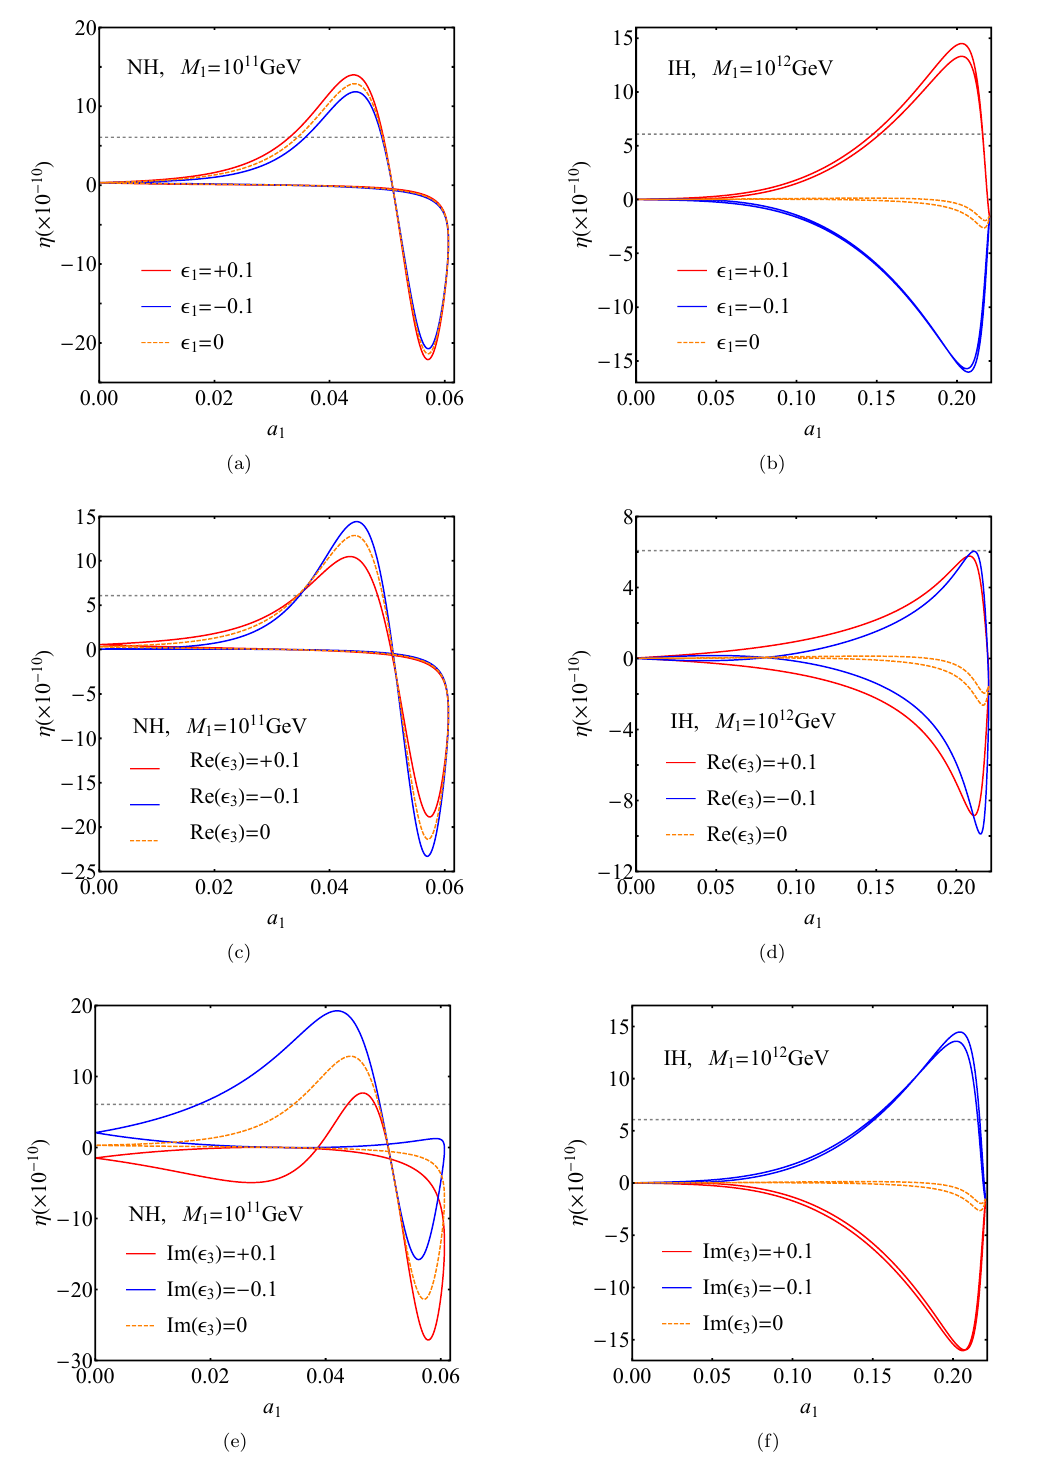
Figure 5 . The (cid:17) (as functions of a breaking parameters for the situation of 10 9 GeV < M for the observed value of (cid:17)